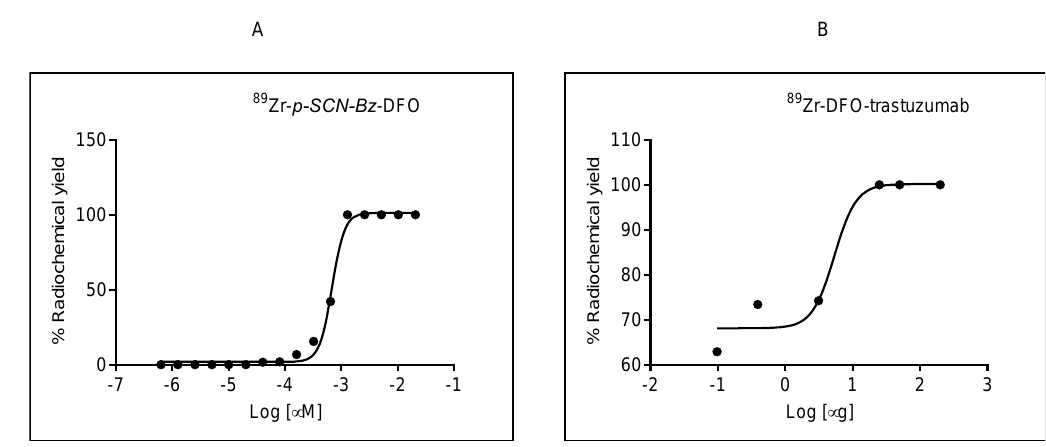
Figure 4. ( A ). Sigmoidal dose–response curve of p -isothiocyanatobenzyl-desferoxamine DFO) – 89 Zr titration, showing effective specific activity of 2323 MBq/µmol. B ) Sigmoidal dose – ( p-SCN-Bz -DFO)– 89 Zr titration, showing e ff ective specific activity of 2323 MBq / µ mol. ( B ) Sigmoidal dose–response curve of 89 Zr-DFO-trastuzumab titration showing e ff ective specific activity of 0.308 MBq / µ g.